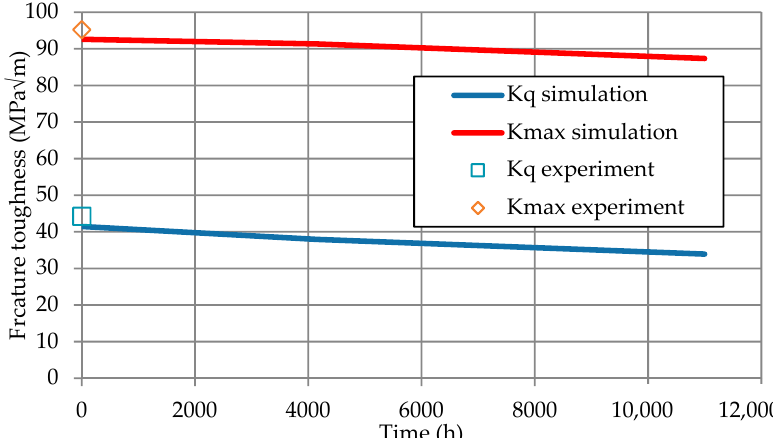
Figure 12. Numerically predicted fracture toughness values vs. ageing time of steel P91 at elevated temperature.